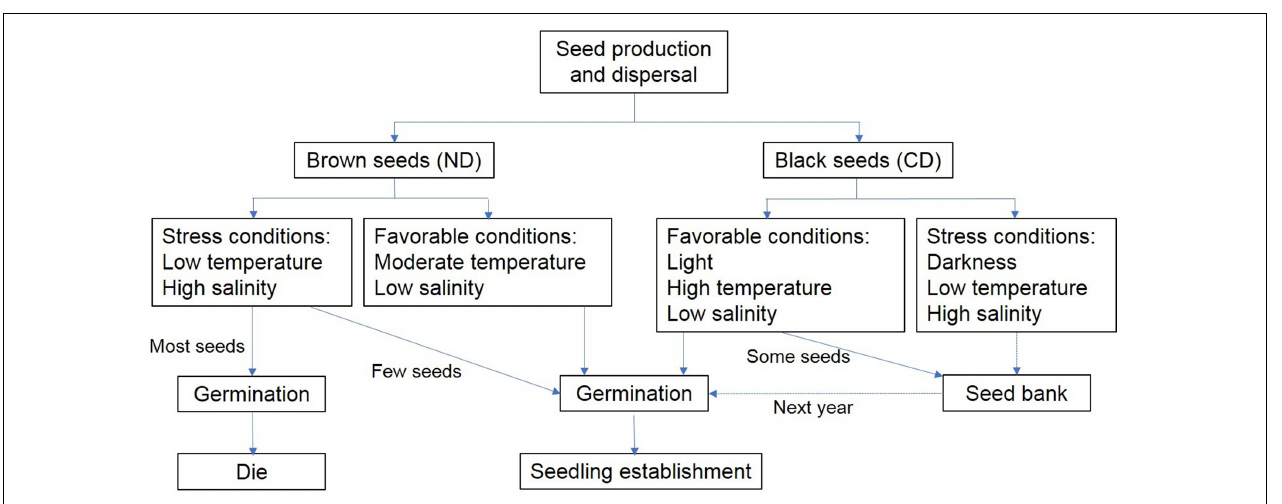
For each treatment there were 10 biological replicates. Different lower-case letters indicate significant differences (P < 0.05, Tukey’s test) in radicle tolerance indexes among different concentration for the same seed type and salt type. Different upper-case letters indicate significant differences (P < 0.05, Tukey’s test) between dimorphic seeds at the same concentration of NaCl or Na 2 SO 4 .